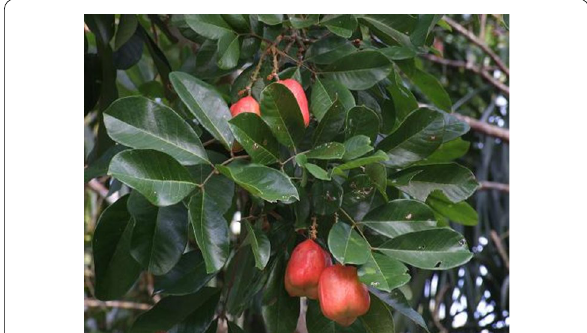
Fig. 1 Leaves and fruits of B.